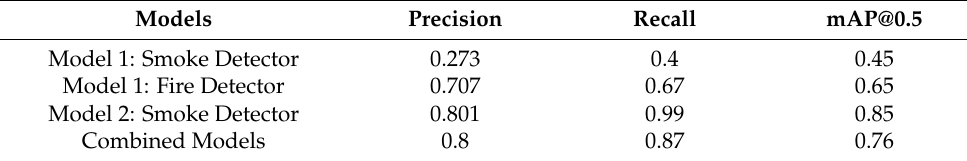
Table 3. Fire and smoke detection experimental